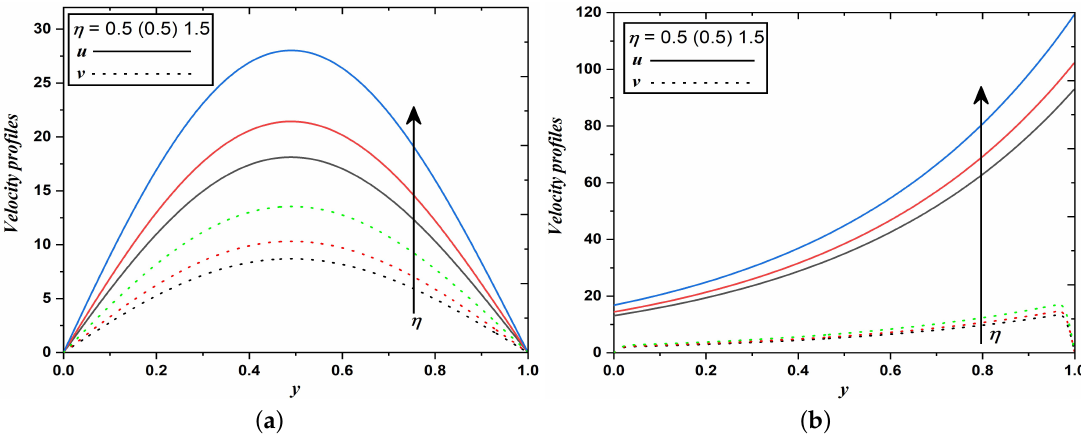
Figure 3. Velocity profiles when the permeability of porous medium varies (Case 1 &